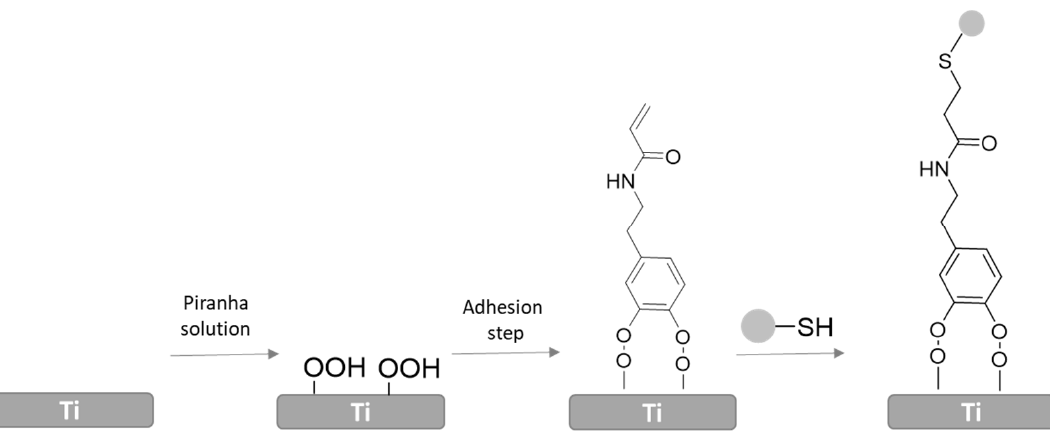
Figure 8. Schematic representation polyNaSS immobilization via catechol strategy and click chemistry.